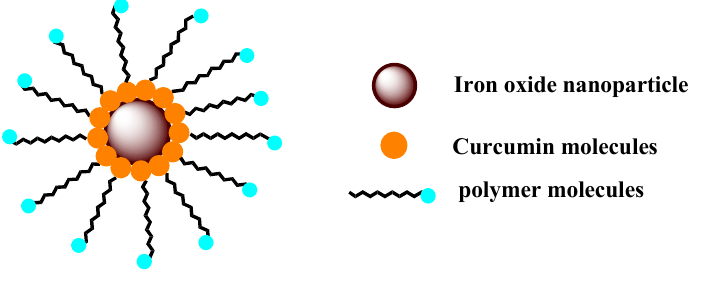
Figure 4. Polymer stabilized curcumin functionalized iron oxide magnetic nanoparticles.